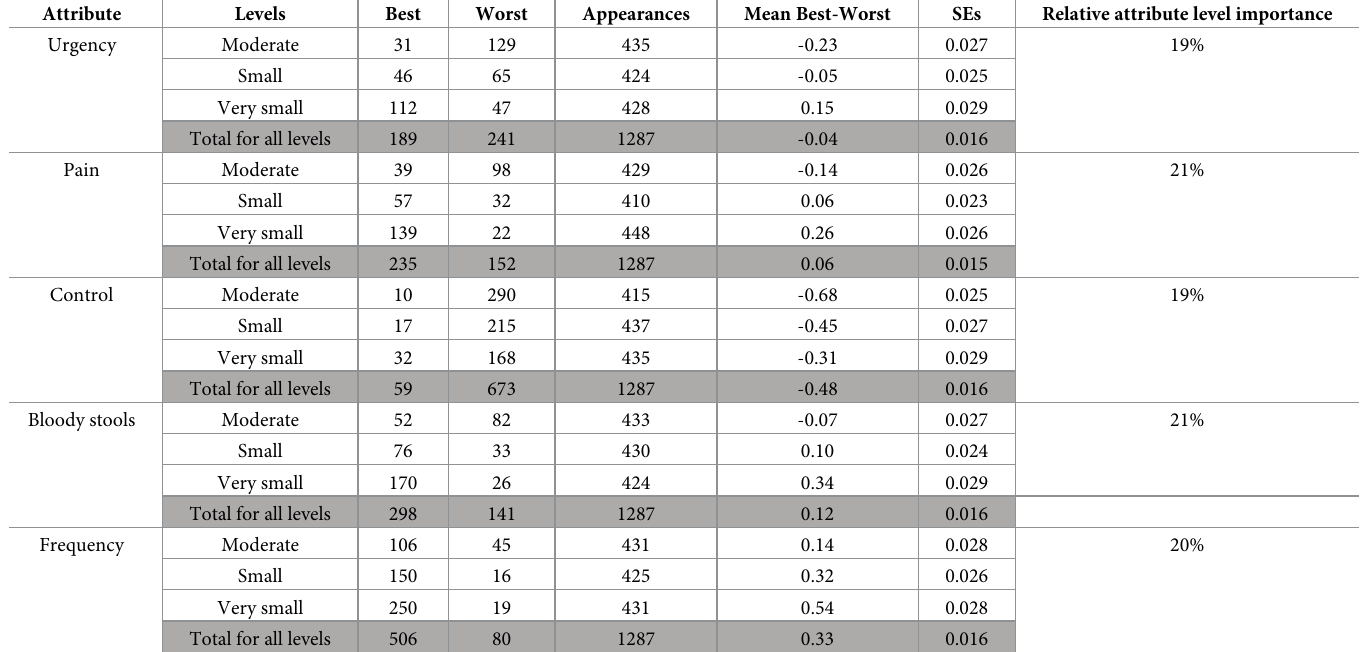
Table 2. Best worst counts and scores for attribute levels and relative attribute level